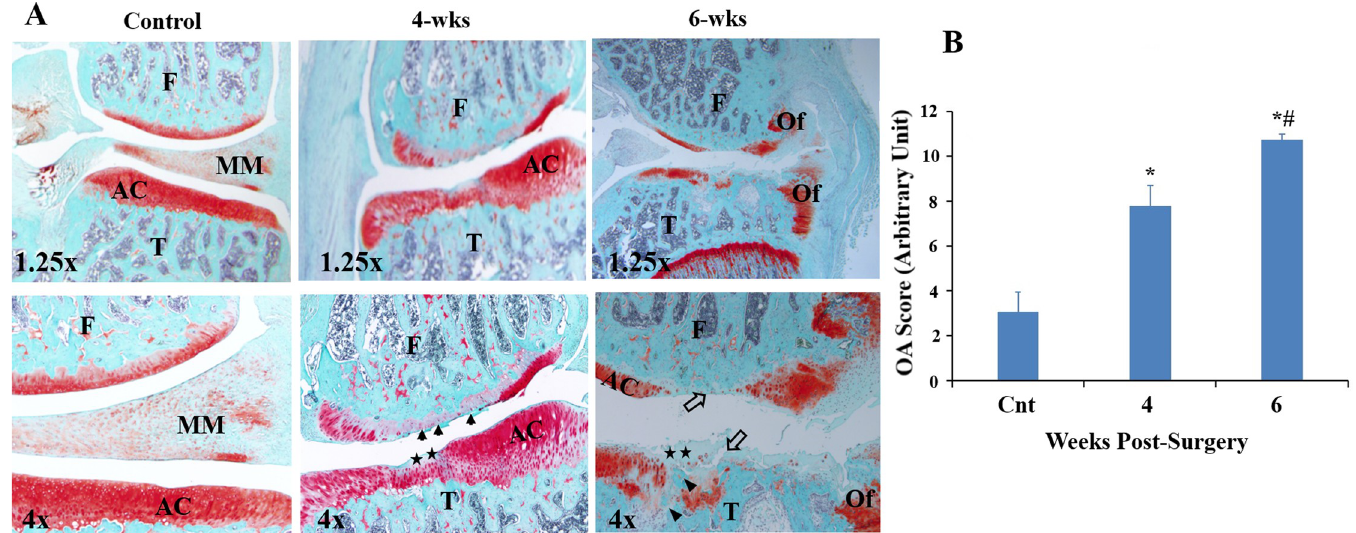
Fig 1. Histopathological evaluation of cartilage of rat knee joints post-MMD at 4 and 6 weeks post surgeries. (A) Representative images of histology sections from the medial side of knee joints isolated from, a control unoperated 17-week-old rat, a 15-week old rat at 4 weeks post-surgery (4-wks), and 17-week-old rat, at 6 weeks post- surgery (6-wks). The section from control unoperated knee shows smooth with no disruption of the articular cartilage surface integrity. Representative image of the medial condyle and tibia plateau of the MMD-knee, isolated at 4 weeks post-surgery, shows irregularities at the superficial layer of the articular cartilage (AC), fibrillation (black arrows) and loss of Safranin-O staining at the superficial zone (black stars). Image of the medial condyle and tibia plateau, isolated at 6 weeks post-surgery, shows severe cartilage degeneration, loss of Safranin-O staining (black stars) and depletion of chondrocytes (open arrows) with irregular trabecular bony between the junction of calcified cartilage (black arrowhead), and osteophyte formation (Of). Sections were stained with Safranin-O/Fast Green and observed using microscope objective lenses 1.25x and 4x., AC. for articular cartilage; Of. for osteophytes; T. for tibia plate and F. for femoral condyle. (B) Microscopic examination of the safranin-O stained sections. The changes in the articular cartilage were graded based on the changes in structure (0–6 points), cellularity (0–3 points), matrix staining (0–4 points), and tidemark integrity (0–1 points), and has a maximum of 14 points. The final score for each knee joint was based on the most severe histologic changes observed from multiple sections of each specimen. Data are presented as mean of 6 knees ± SE, n = 6. � P < 0.05 vs control unoperated knees, #P < 0.05 vs MMD-Knees at 4 wk-post- surgery.